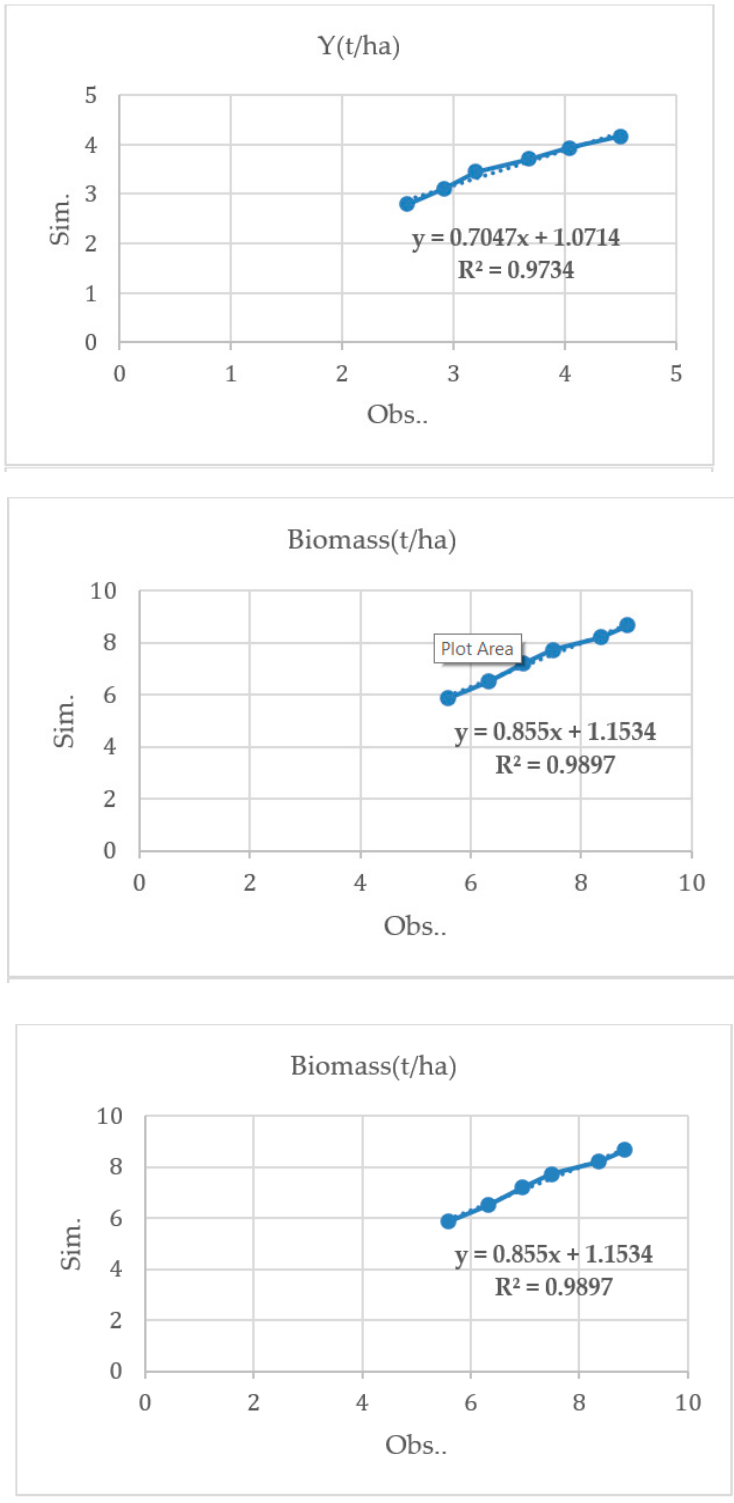
Figure 2. The results of model calibration for simulating grain yield, biomass, and water use efficiency for the winter wheat crop under different irrigation conditions.